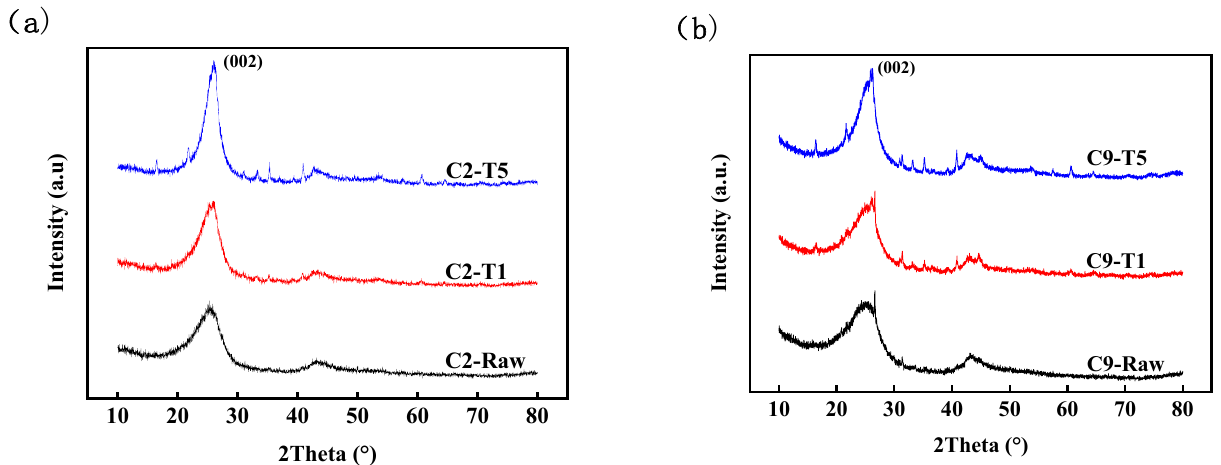
Figure 4. The SEM images of C9: ( a ) raw, ( b ) and ( c ) after reaction under T1 and T5.